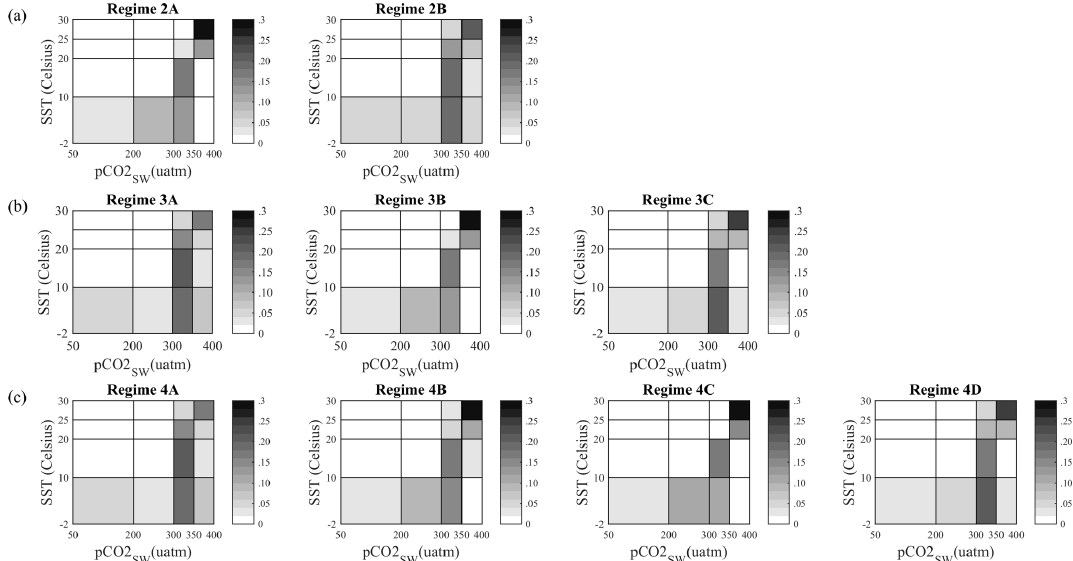
Figure 4. Cluster analysis output (regimes) for (a) k = 2, (b) k = 3, and (c) k = 4 for the North Atlantic, from the Takahashi observational dataset. The color bar represents the relative frequencies of occurrence of each value-pair interval; i.e., the frequencies are divided by the total number of frequencies per